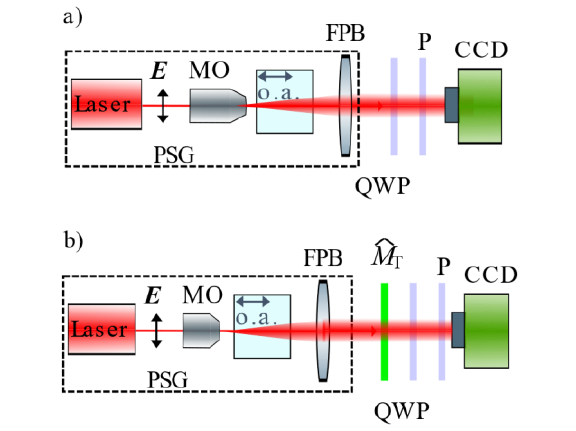
Fig. 1. Experimental scheme for Mueller FPB Polarimetry without (a) and with (b) a sample. E: MO: objective of microscope, o.a.: optical axis of a calcite crystal; L: lens QWP: quarter wave phase plate; P: